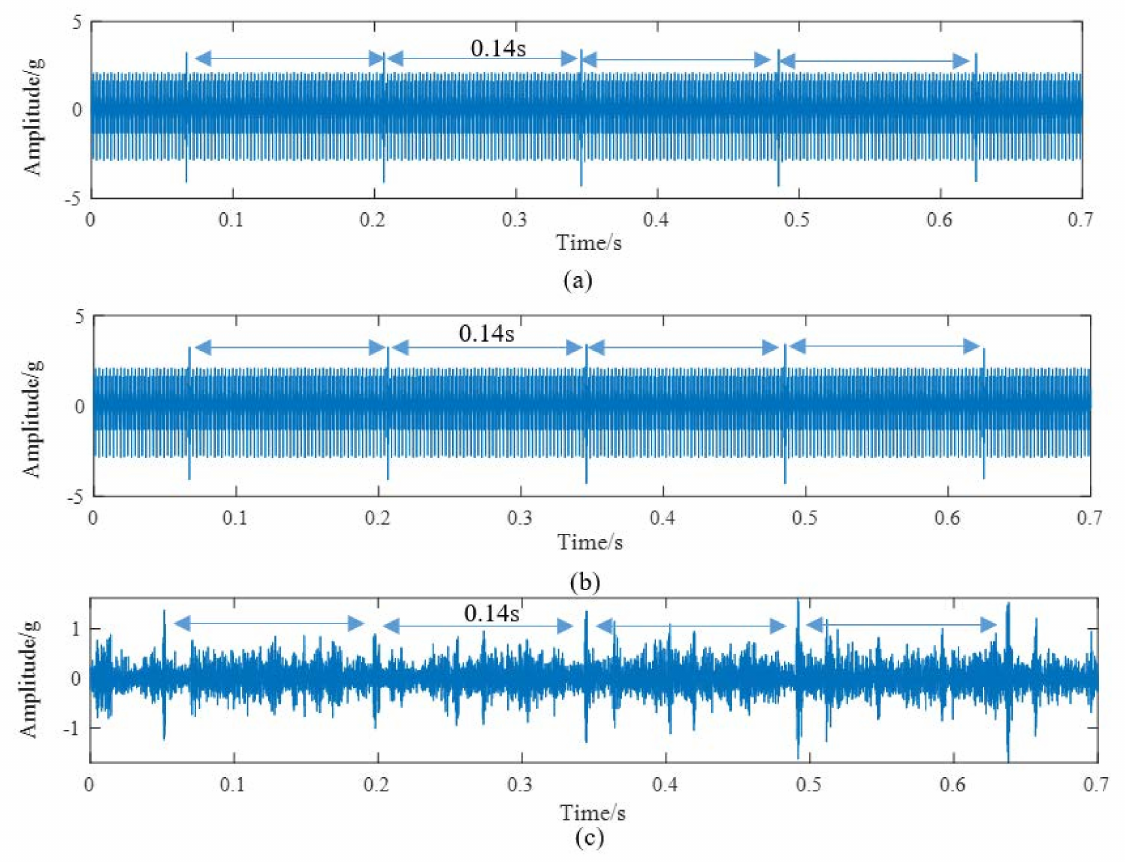
Figure 12. Time domain signals of tooth spalling: ( a ) Simulation signal of rectangular spalling, ( b ) Simulation signal of elliptical spalling, ( c ) Experimental signal of elliptical spalling.